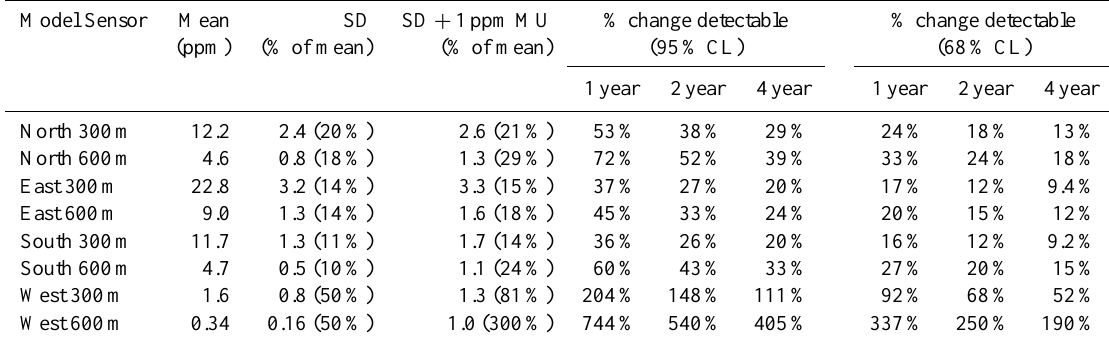
Table 2. Modelled mean CO 2 ff and standard deviation (SD) of eight hypothetical sensors simulated over the eight years 2004–2011 with constant emissions. Measurement uncertainty (MU) of 1.0ppm is added to the standard deviation in the fourth column. Columns 5–10 show the detection limits calculated at the 2-sigma (95%) and 1-sigma (68%) confidence level (CL) for samples representing an average of one, two, or four years. Measurement uncertainty (MU) of 1.0ppm is added in quadrature to the standard deviation of modelled CO 2 ff before limits are